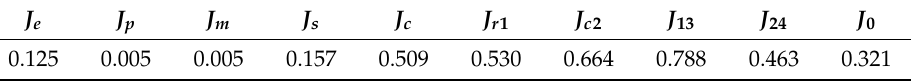
Table 4. Equivalent moment of inertia used in the simulation (kg · m 2